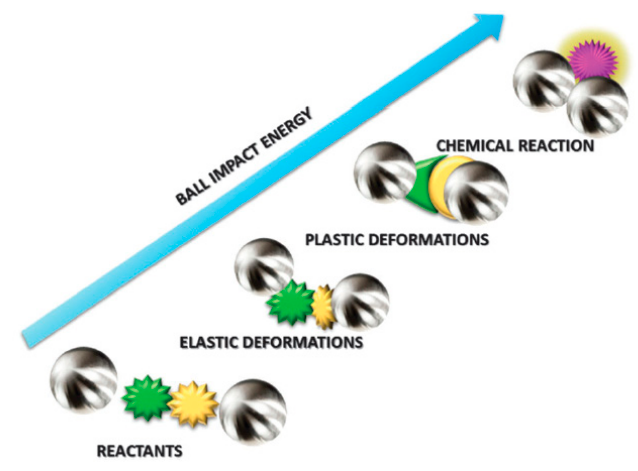
Figure 1. Conversion of reactants to the product in the mechanochemical synthesis. (Reproduced with the permission from Ref. [15]. Copyright © 2015 The Royal Society of Chemistry.)